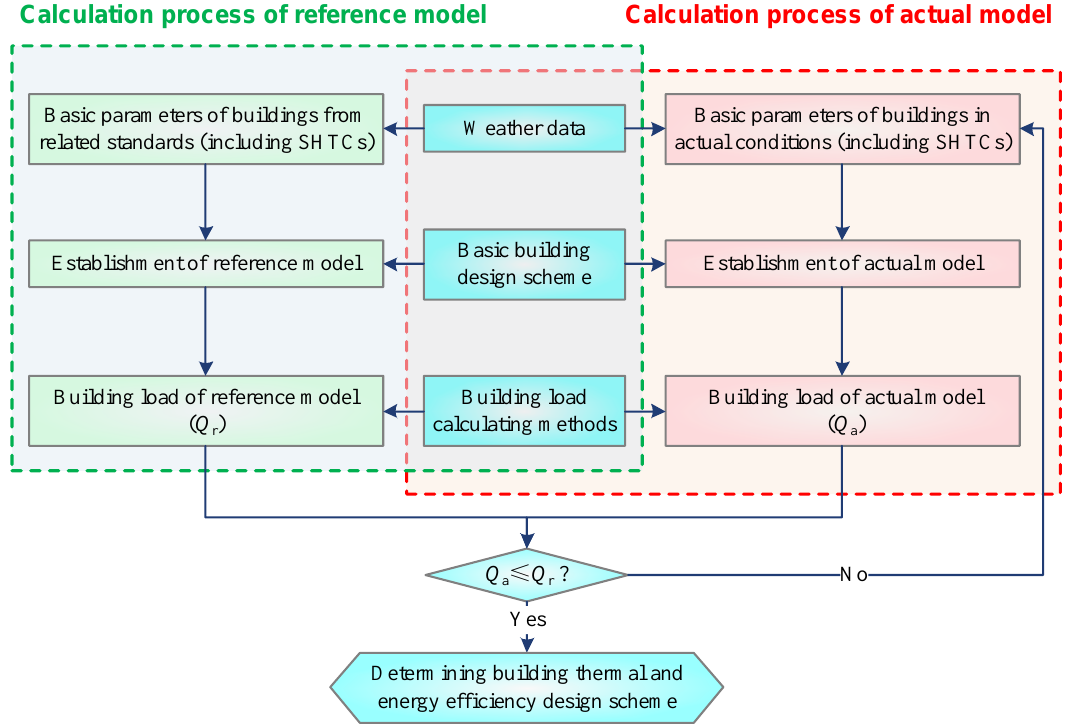
Figure 2. Building load-based trade-off option in building energy efficiency design.